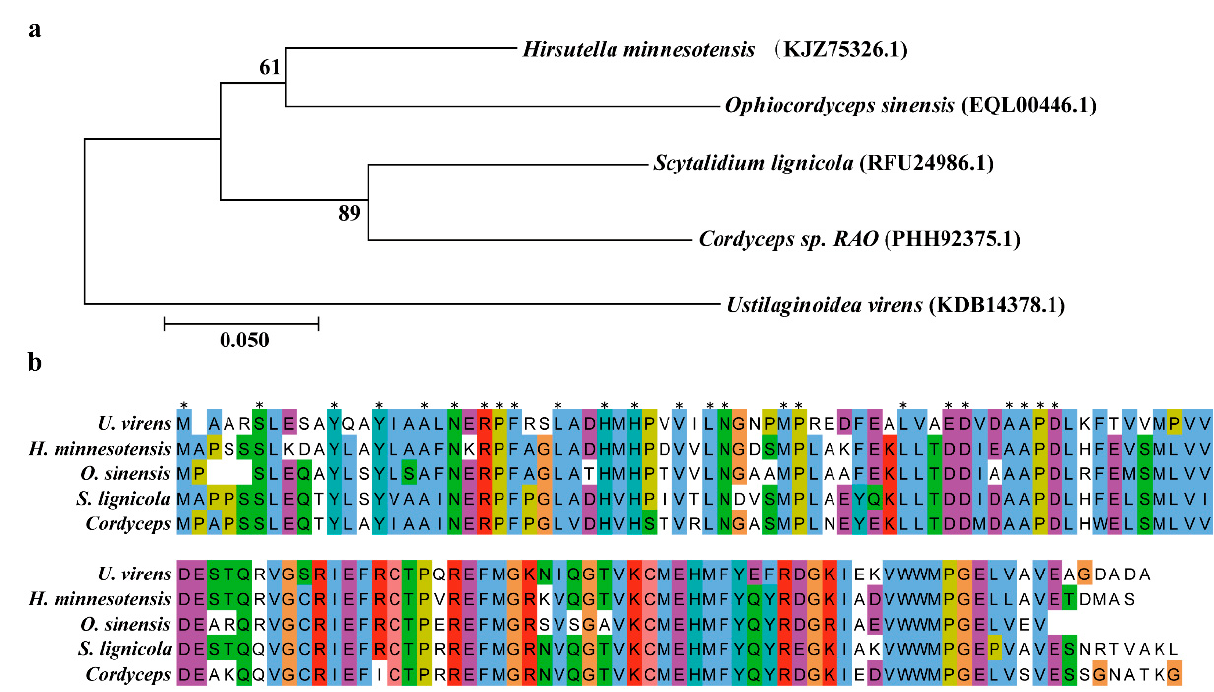
Figure 1. Characterization of UvEC1 in U. virens . ( a ) Neighbor-joining phylogenetic tree of putative EC1 homologs encoded by 5 fungal genomes generated with MEGA7.0. The numbers at each branch node are bootstrap percentages out of 1000 replicates. ( b ) The mutiple alignment of EC1 homologs proteins amino acid sequences of H. minnesotensis , S. lignicola , Cordyceps and O. sinensis .